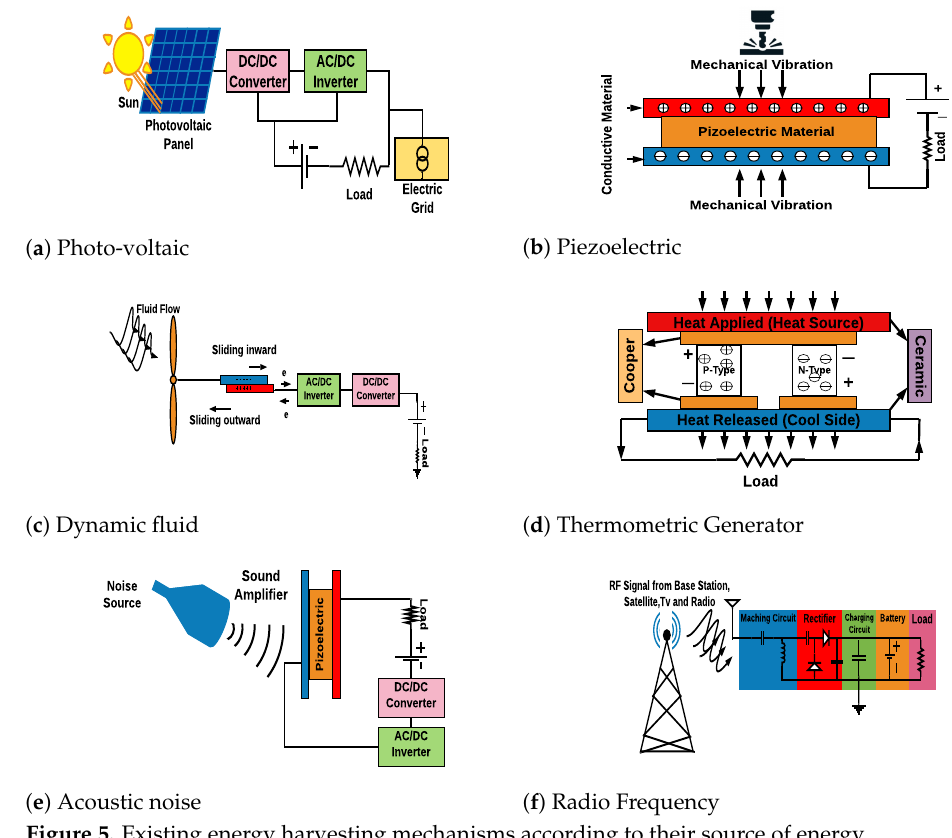
Figure 5. Existing energy harvesting mechanisms according to their source of